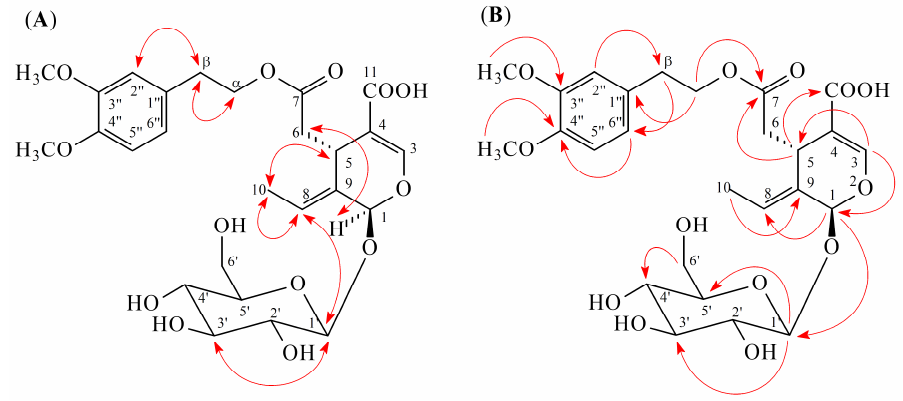
Figure 4. Key NOESY ( A ) and HMBC ( B ) correlations of 3 .